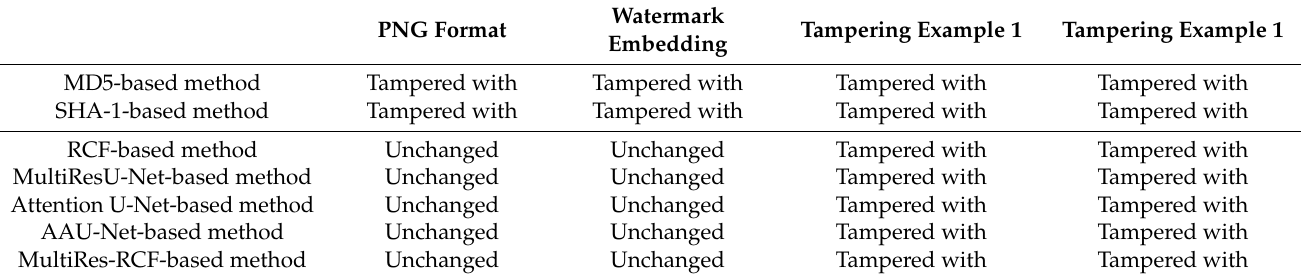
Table 4. Integrity authentication results after each operation are shown in Figure 6 (threshold T is set to